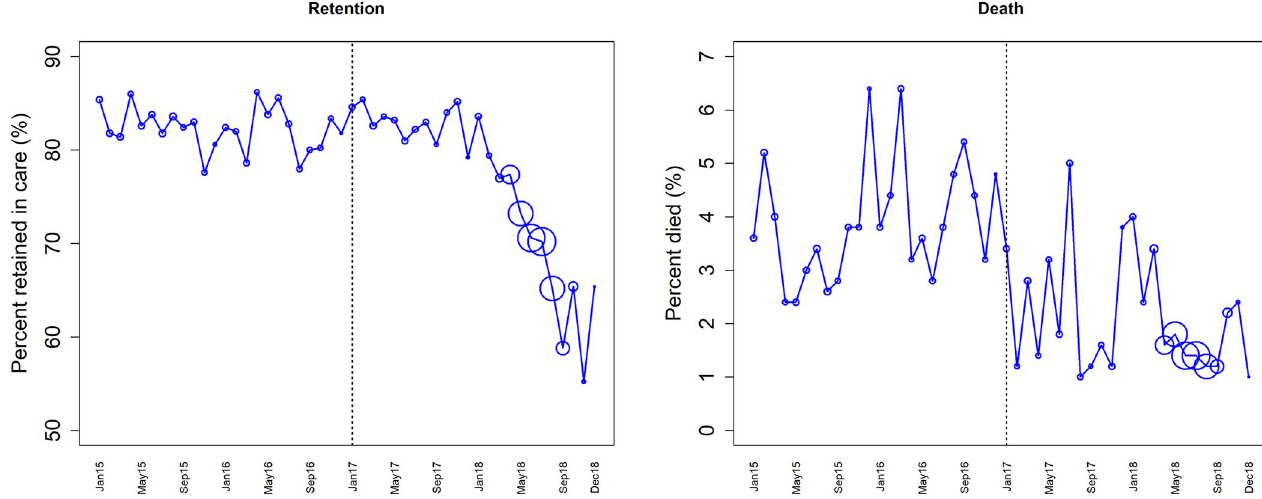
Fig 3. Time series trends showing six-month retention and six-month mortality for cohorts enrolled in each month from January 2015 through December 2018 comparing pre-UTT (2015–2016) and UTT (2017–2018) periods separated by a vertical dotted line. The size of the circles corresponds to the number of HIV patients enrolled and included in the